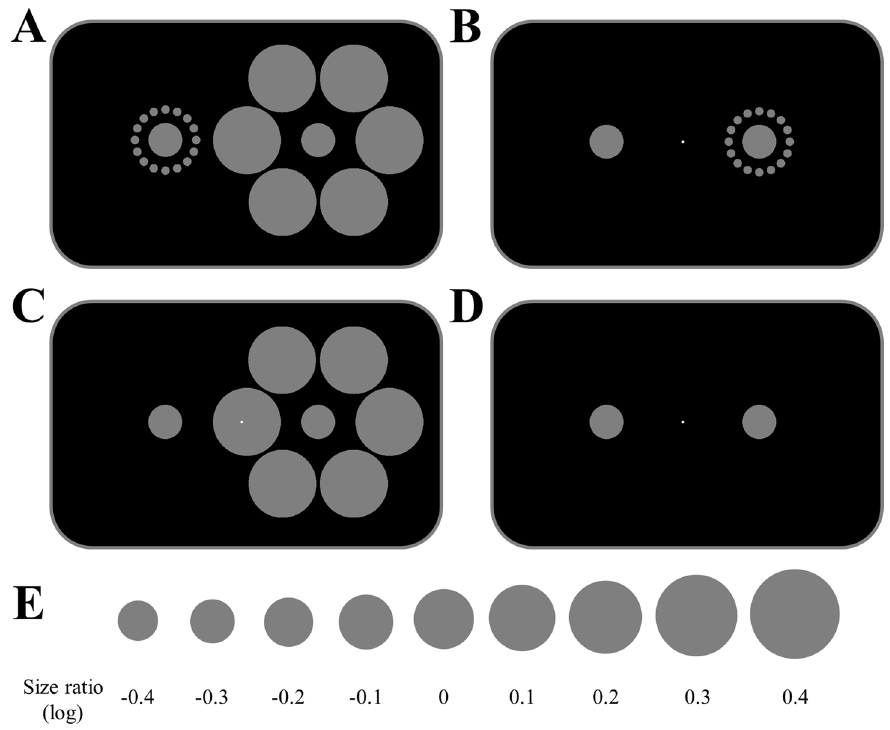
Figure 1. The Ebbinghaus illusion. A. In the classical form of the illusion two identical circles are surrounded by smaller (left) or larger (right) inducers. This causes a perceived difference in the size of the two central circles. B–D. Example stimuli (all without any physical size difference between test and reference) for the three stimulus conditions. Participants fixated the small white dot while two circles were shown to the left or right of fixation. One circle (the left in all these examples) was the reference and always remained constant. The other circle was the test stimulus and could either be surrounded by small inducers (B), large inducers (C), or no inducers (D). The hemifield where the test stimulus appeared was pseudo- randomized and counterbalanced for each participant. E. The size of the test stimulus varied between 9 different test/reference size ratios on a logarithmic scale (shown here schematically).